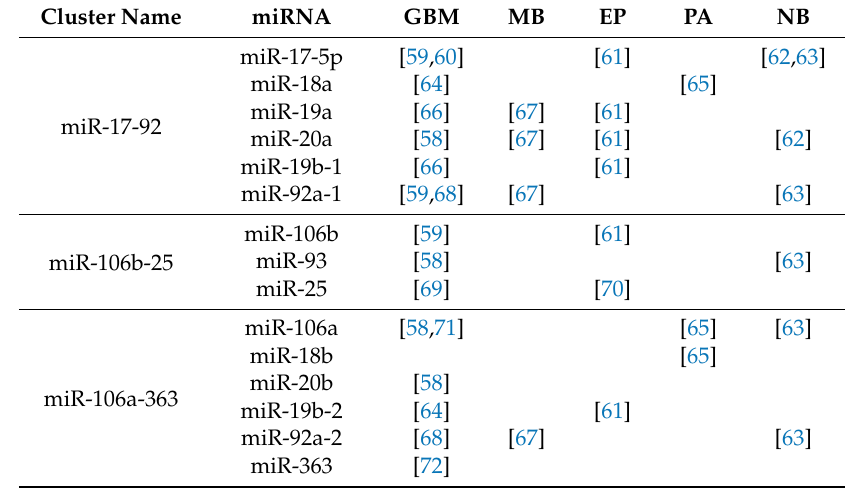
Table 1. Overexpression of miRNAs from miR-17-92, miR-106a-25, and miR-106b-363 clusters in brain tumors and